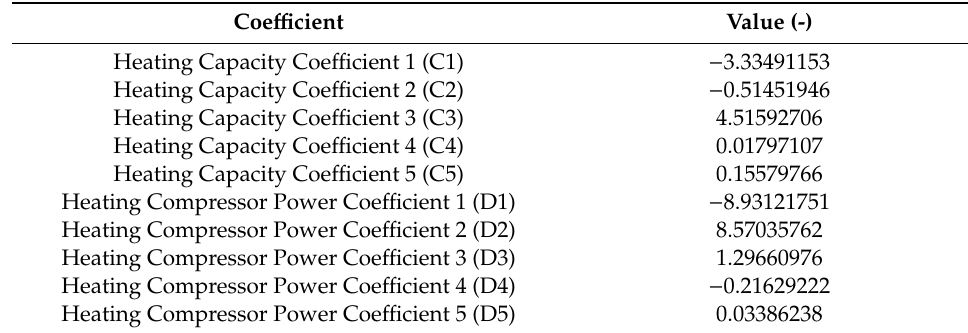
Table 3. Heat pump equation fit model coe ffi